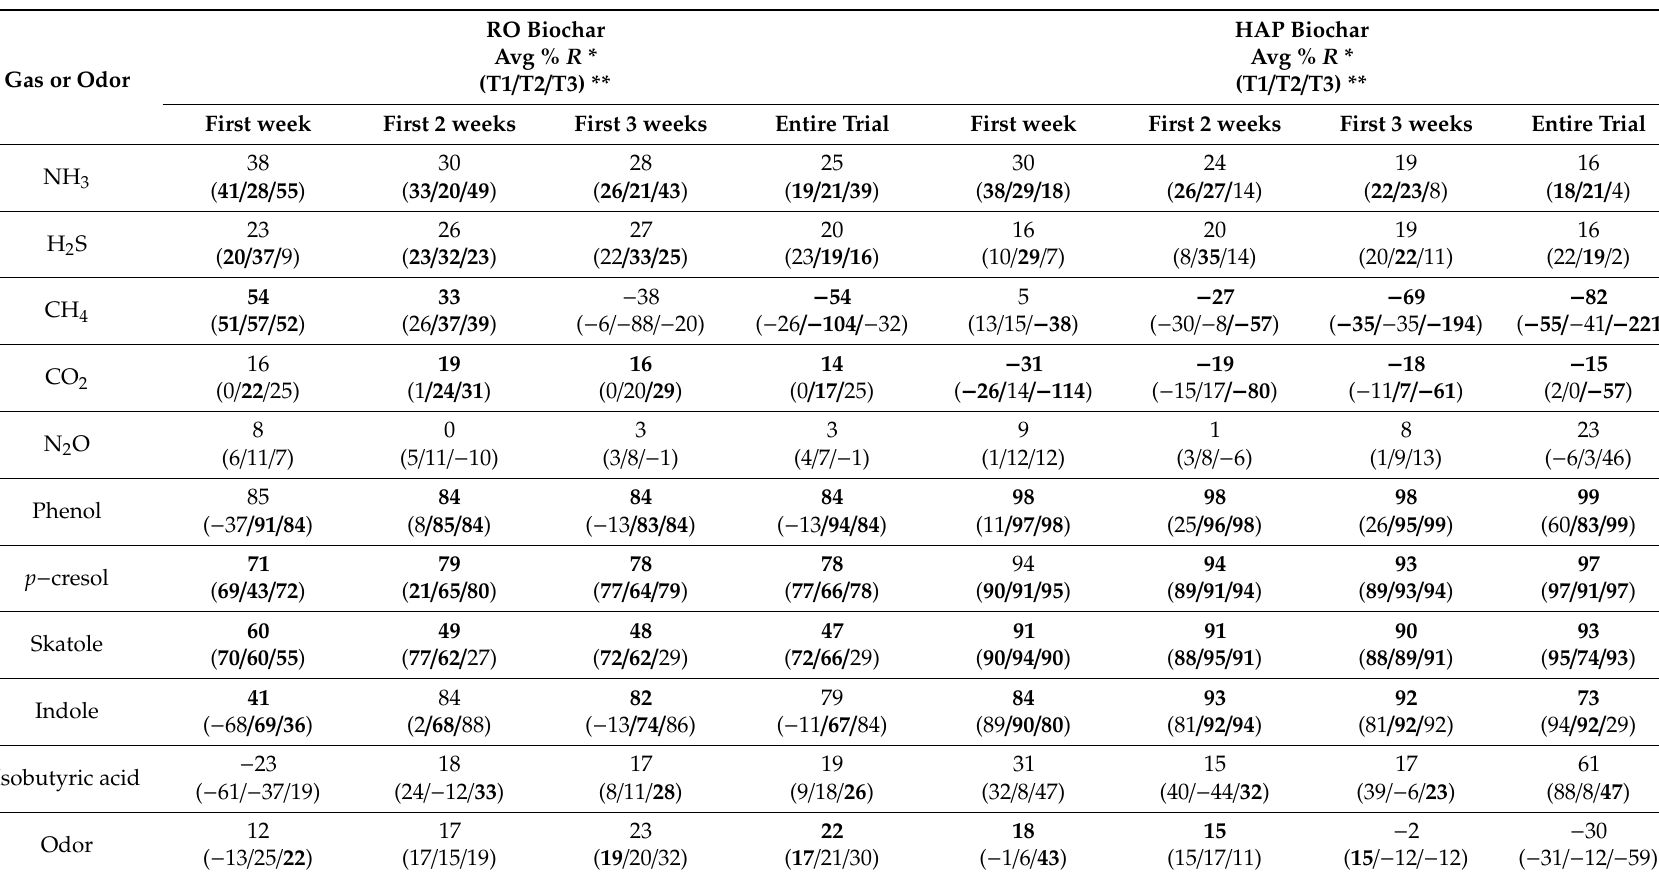
Table 4. E ff ectiveness of RO and HAP biochar treatment of gaseous emissions from stored swine manure. The e ff ect of time (and therefore the duration of the mitigation e ff ect) is reported as the percent reduction (% R ) of measured concentrations for the first week, first 2 weeks, first 3 weeks, and entire trial, respectively. * The average % R (Avg % R ) was estimated based on the average C Con and C Treat from three trials. ** T1 = trial 1, T2 = trial 2, T3 = trial 3; % R was estimated with Equation (1) for each Trial; Bold signifies statistical significance ( p ≤